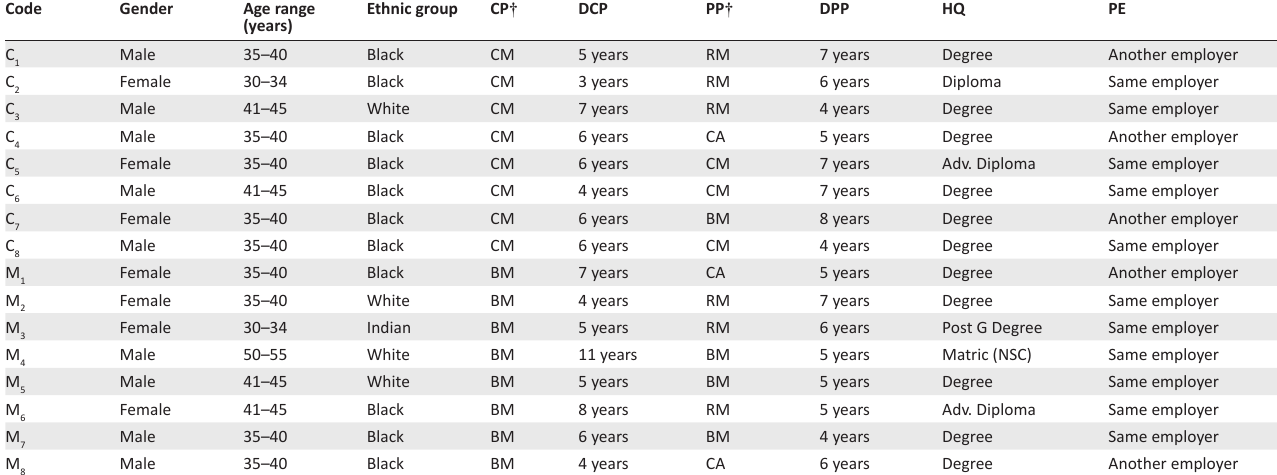
TABLE 1: Biographical